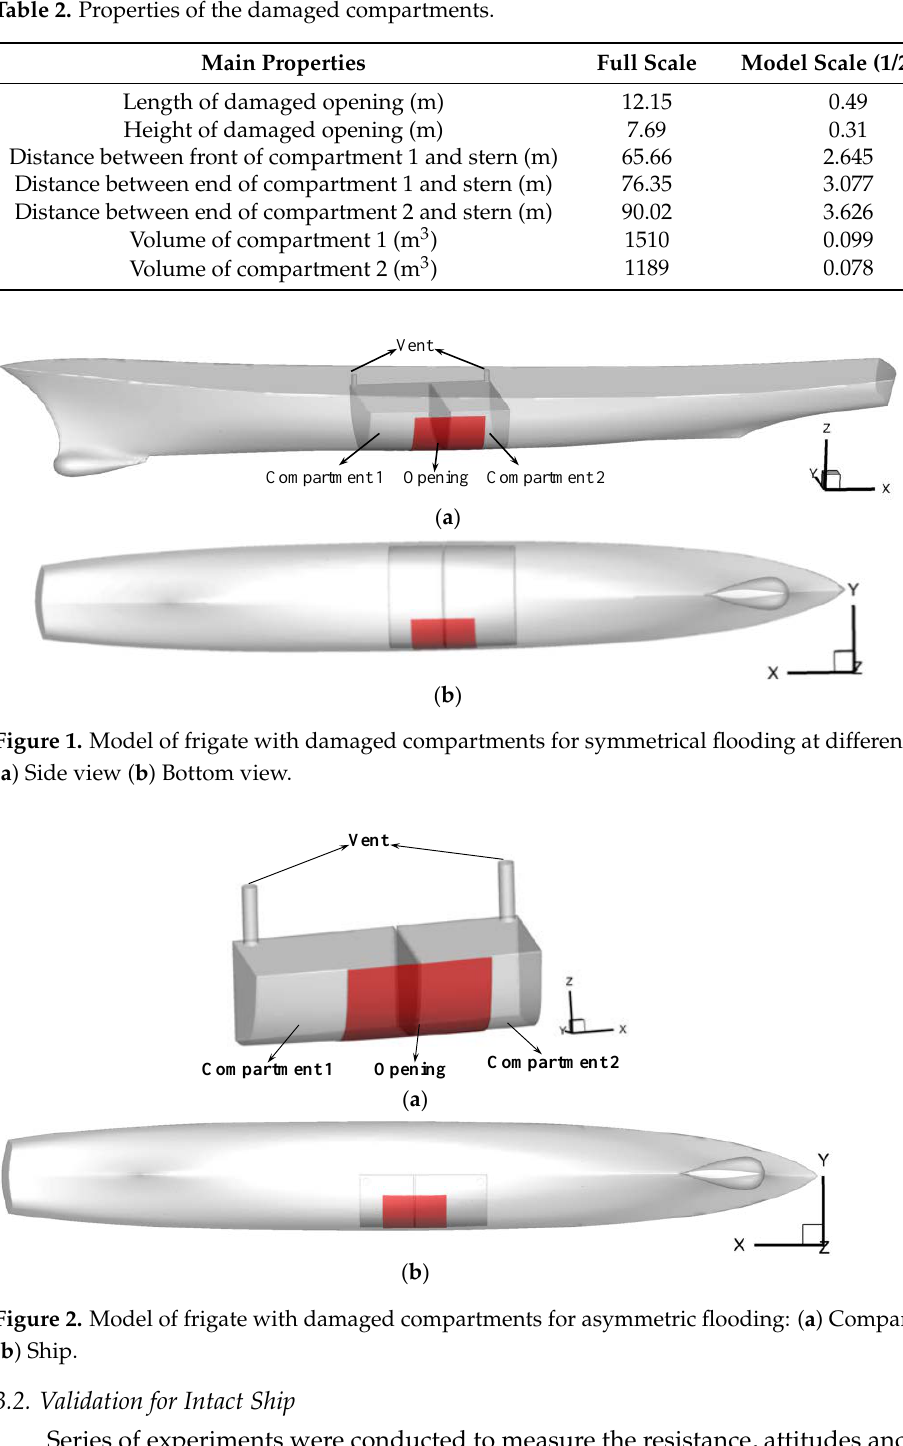
Table 2. Properties of the damaged compartments.